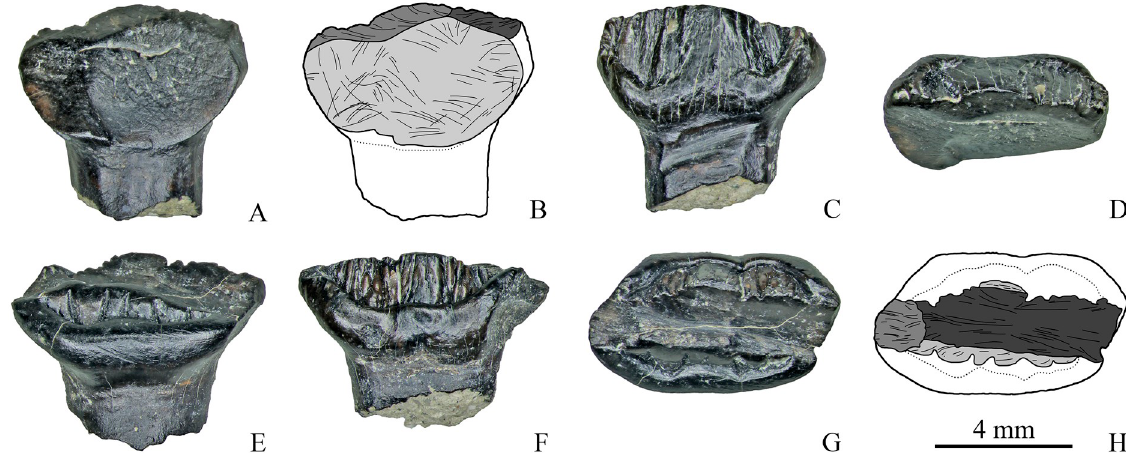
Fig 10. Dentary teeth with three wear facets of Stegosauria indet. from the Teete locality, Yakutia, Russia; Batylykh Formation (Lower Cretaceous). Specimens ZIN PH 13/246 (A-D), ZIN PH 19/246 (E-H) in labial (A, E), lingual (C, F), occlusal (D, G) views, and interpretive drawings in labial (B) and occlusal (H) views showing the wear facets with scratches.